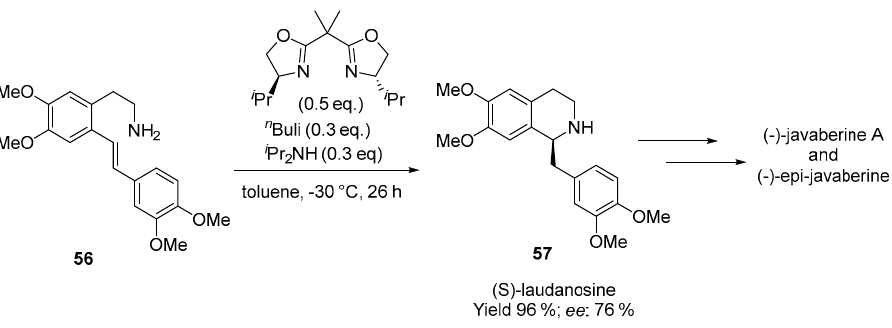
Table 15. Catalytic asymmetric intermolecular hydroamination of vinylarenes 58a , b with amines 59a , b using the chiral lithium catalytic system 49a , b a